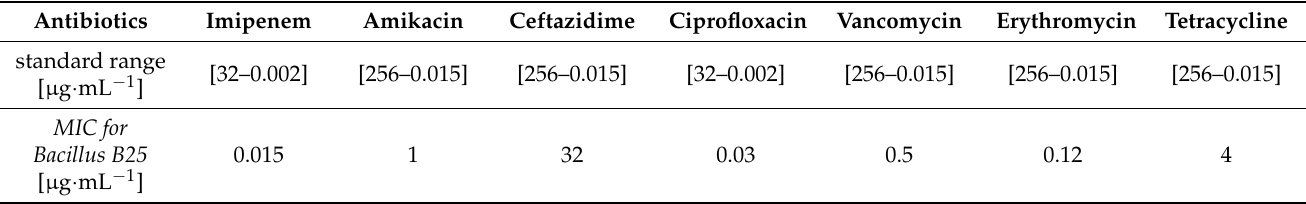
Table 6. Minimal inhibitory concentrations (MICs) of antibiotics obtained for Bacillus methylotrophicus strain B25. Antibiotics standard range